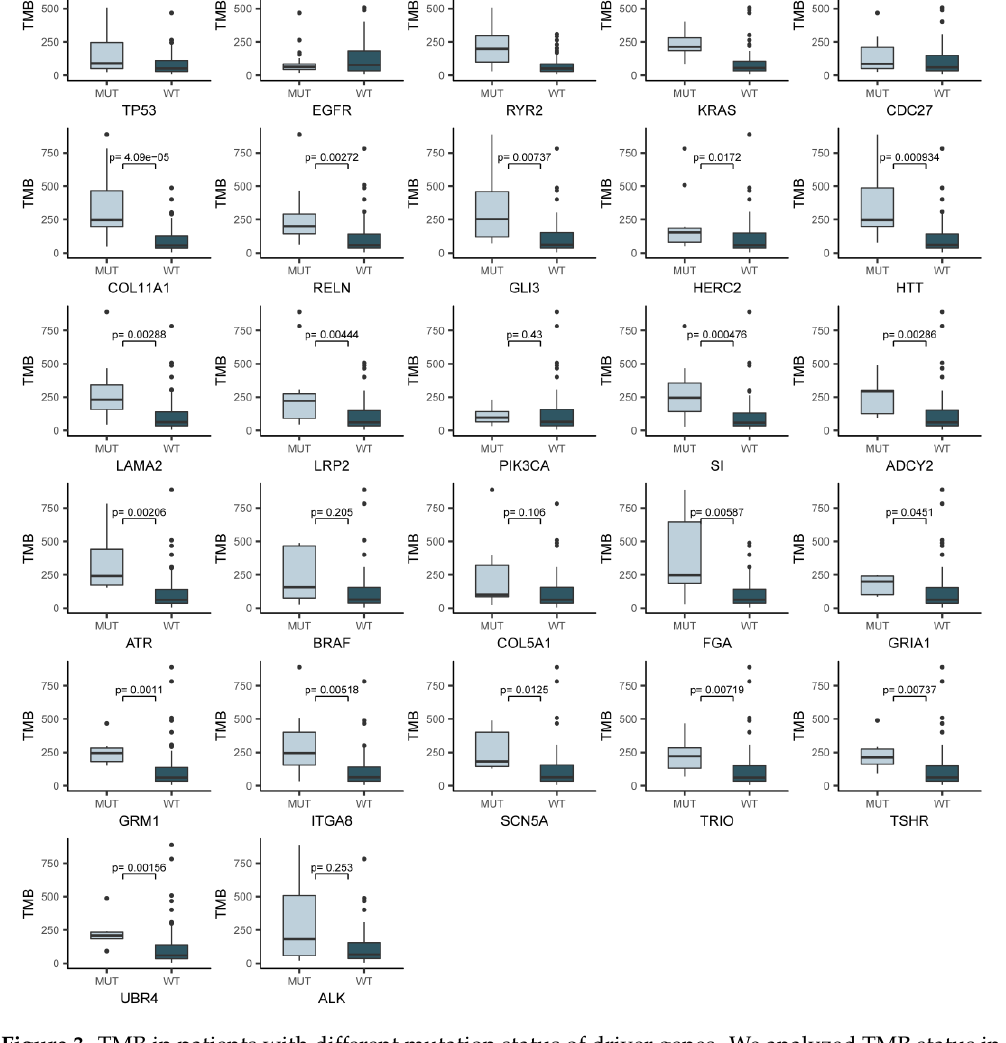
Figure 3. TMB in patients with different mutation status of driver genes. We analyzed TMB status in patients with all 27 different somatic driver genes identified in at least five cases from the total 101 cases of the LUAD_BGI cohort. Notably, TMB is most significantly higher among patients with vs. patients without an alteration in RYR2 . MUT: mutation; WT: wild type.